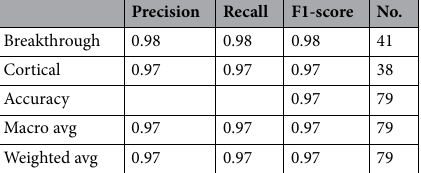
Precision Recall F1-score